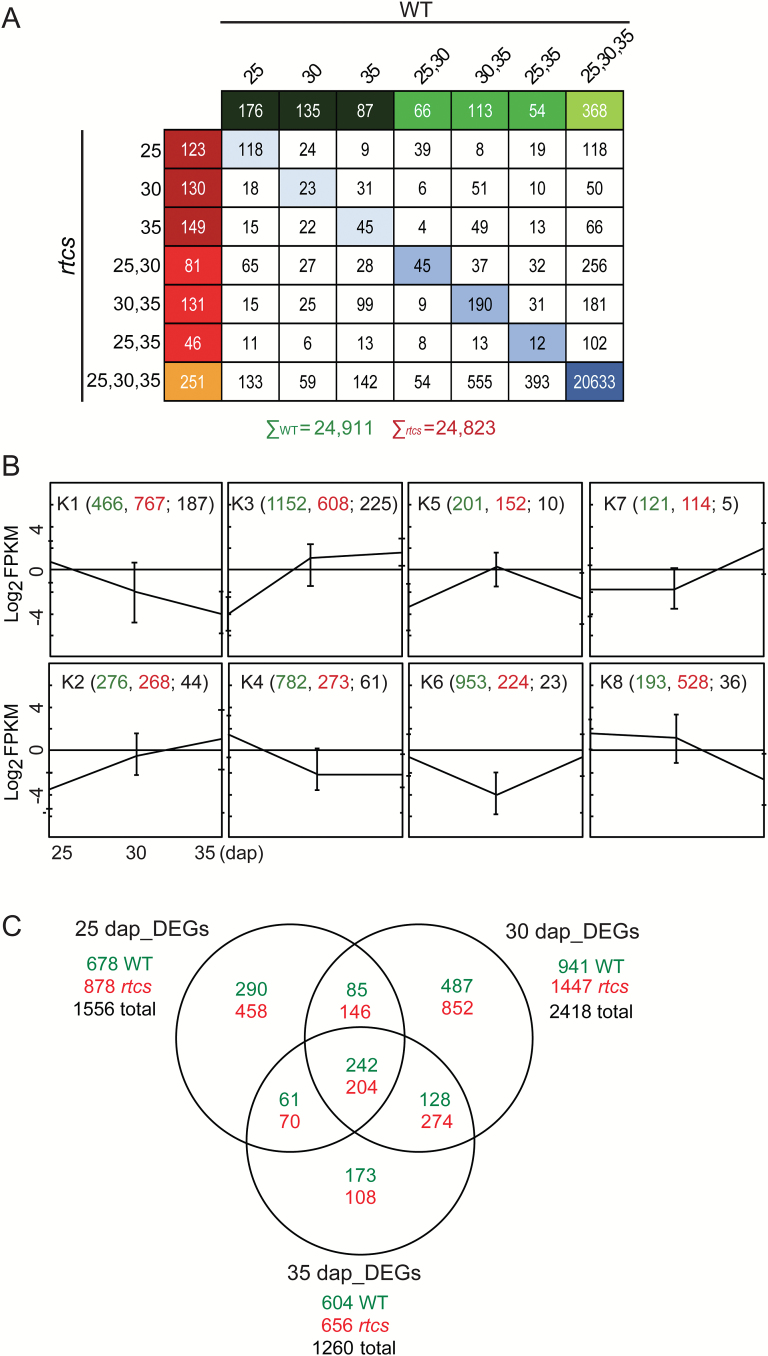
Differential gene expression during embryo development and between wild-type (WT) and rtcs embryos. (A) Stage and genotype specificity of gene activity in wild-type and rtcs embryos. Cells in green indicate genes exclusively active in wild-type and cells in red indicate genes only active in rtcs embryos. Cells in blue indicate genes active in both genotypes at the same stage or stages. (B) K-means clustering showing the pattern changes of gene expression across the three stages in wild-type and rtcs embryos. Error bars indicate SD of gene expression in wild-type embryos. Numbers in green and red indicate the genes following the respective pattern in wild-type and rtcs embryos, respectively. Numbers in black indicate genes displaying identical patterns in both rtcs and wild-type embryos. (C) Venn diagram displaying the number of genes differentially expressed between wild-type and rtcs and their overlap during development. For each developmental stage, the total number of differentially expressed genes (black), and the numbers of genes preferential expressed in wild-type (green) and rtcs (red) are indicated. DEGs, differentially expressed genes; dap, days after pollination.